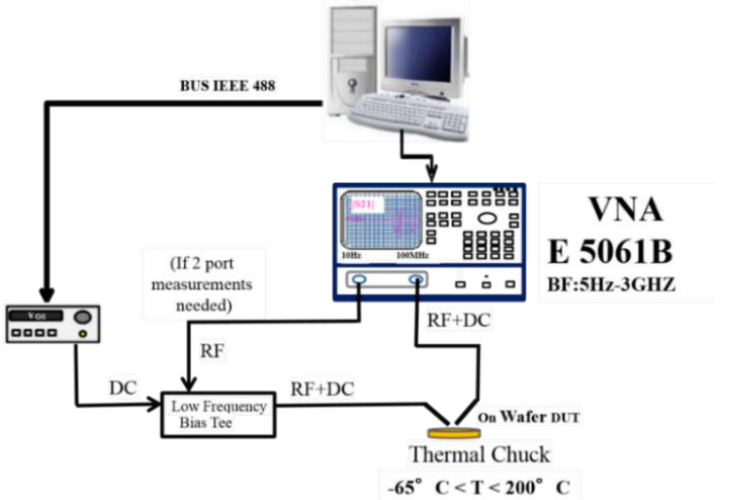
Figure 2. The experimental setup of the LF Y -parameter characterization by using an Agilent E5061B vector network analyzer (VNA).